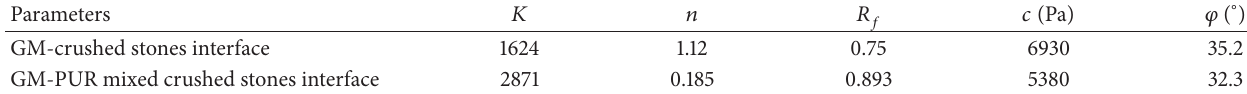
Table 2: Fitting parameters of two interfaces by nonlinear-elastic perfectly plastic